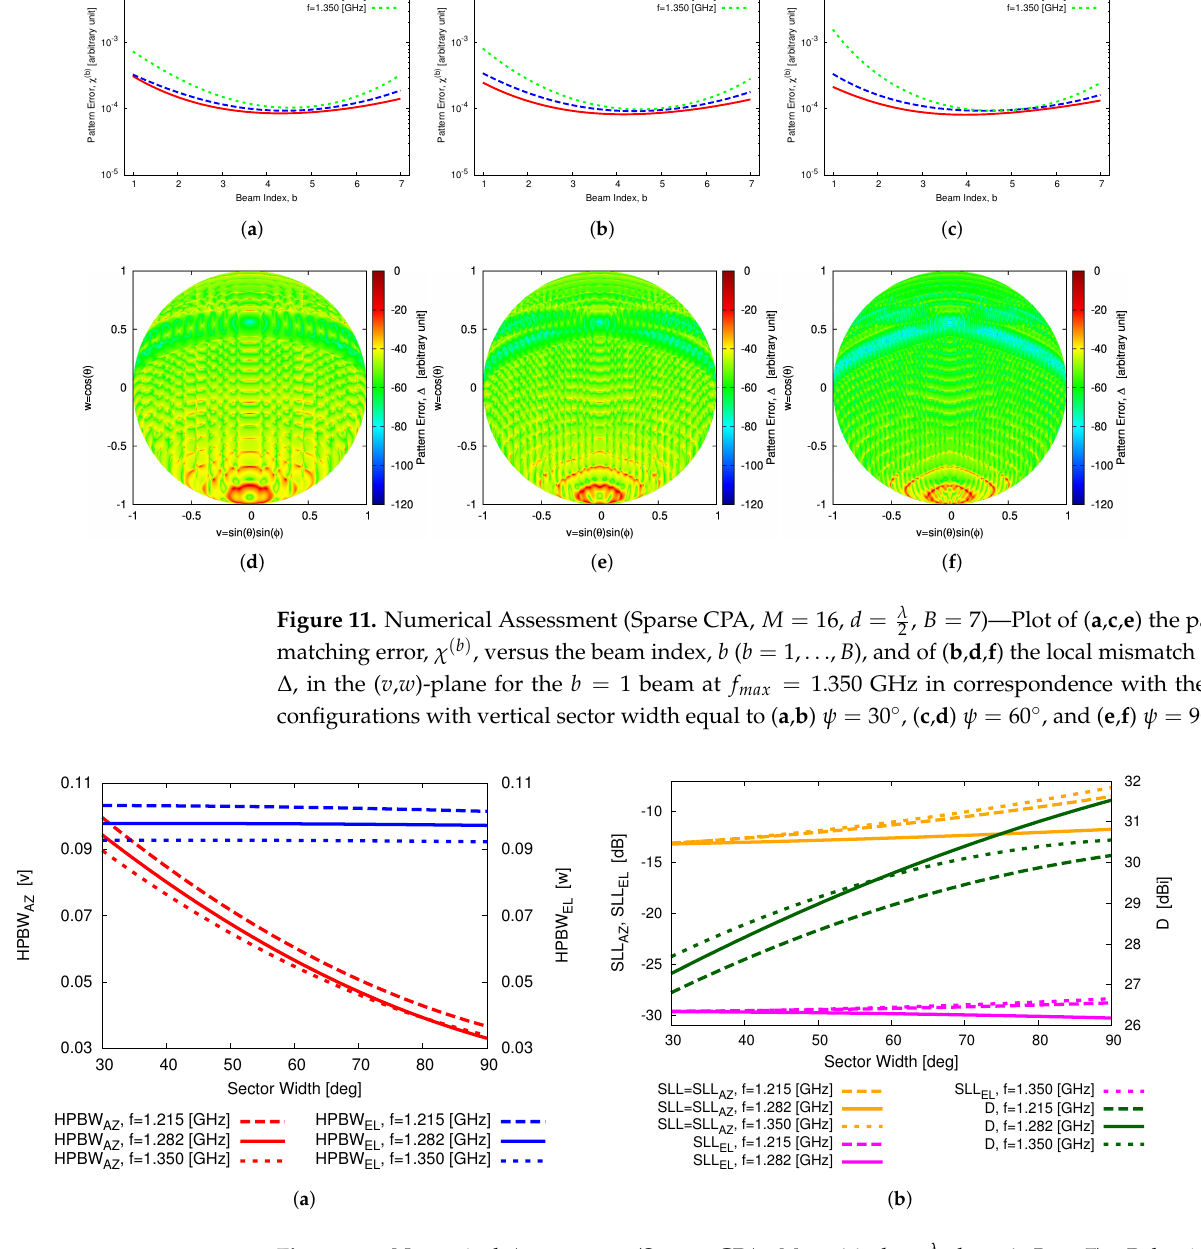
, b = 4, B = 7)—Behaviour of 2